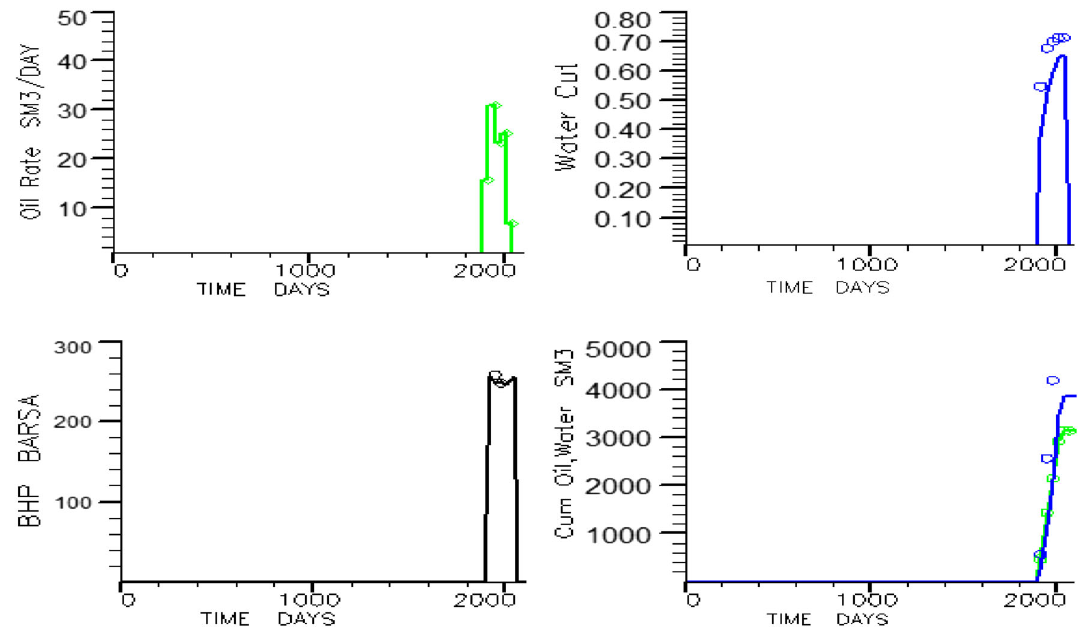
Fig. 8 History match results at well level for Well-49